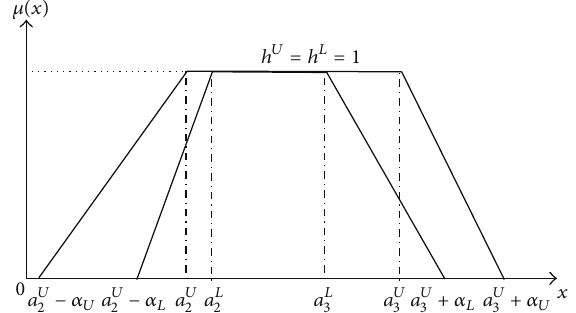
̃𝐴 𝐿 and the ̃𝐴 ̃𝐴 𝑈 of PnIT2FS